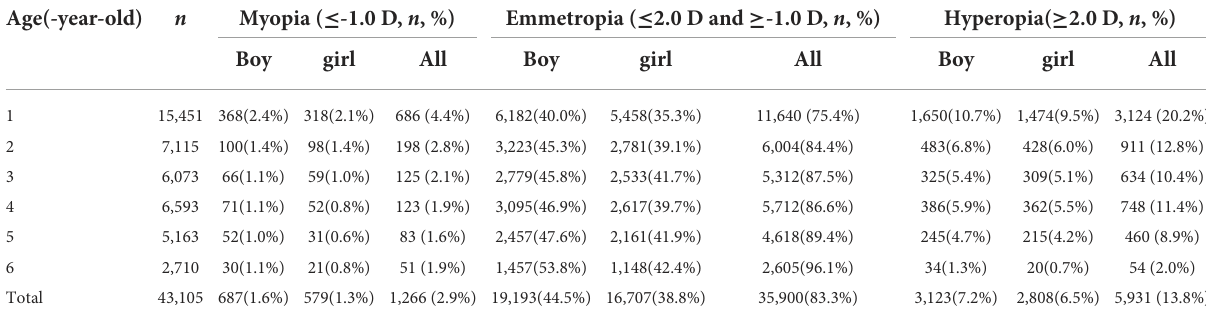
TABLE 4 The proportion of myopia, emmetropia, and astigmatism with different thresholds in 1–6 years old children.